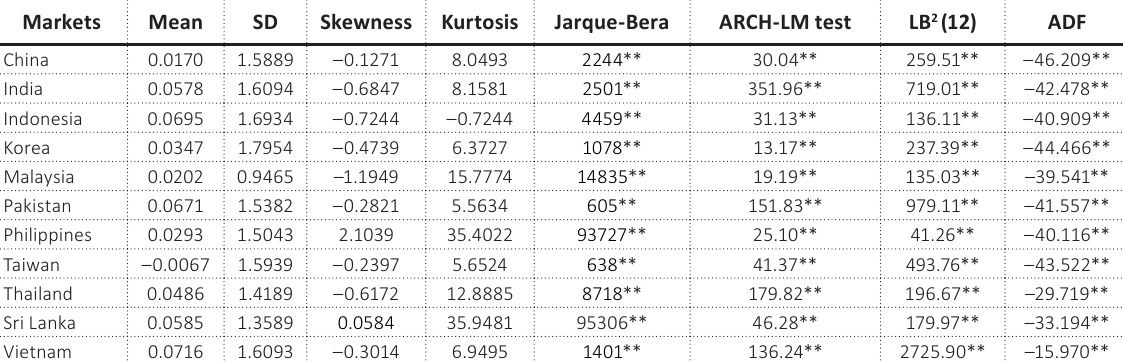
Table 2. Descriptive statistics of the stock returns during pre-global financial crisis Markets